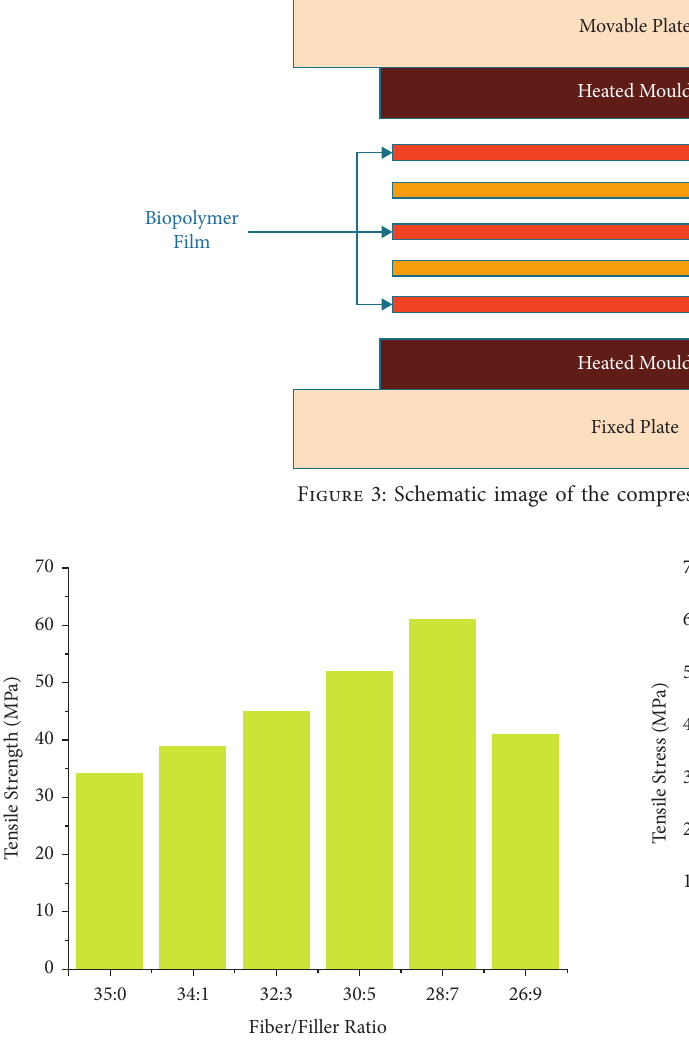
Figure 4: Epoxy resin/madar fibre/sugarcane bagasse ash com- posites: effect of fibre/filler loading on tensile strength.